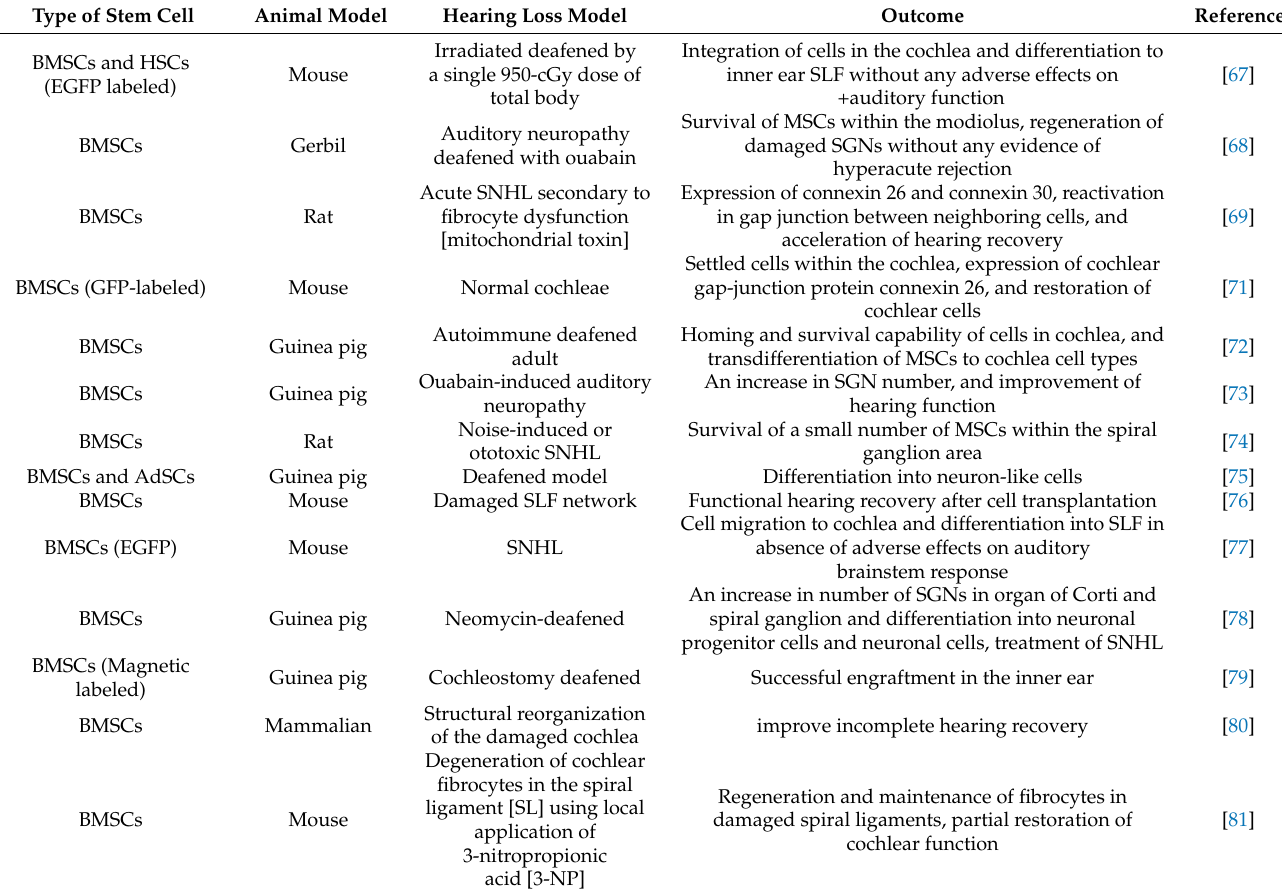
Table 1. In vivo studies in treatment of inner ear hearing